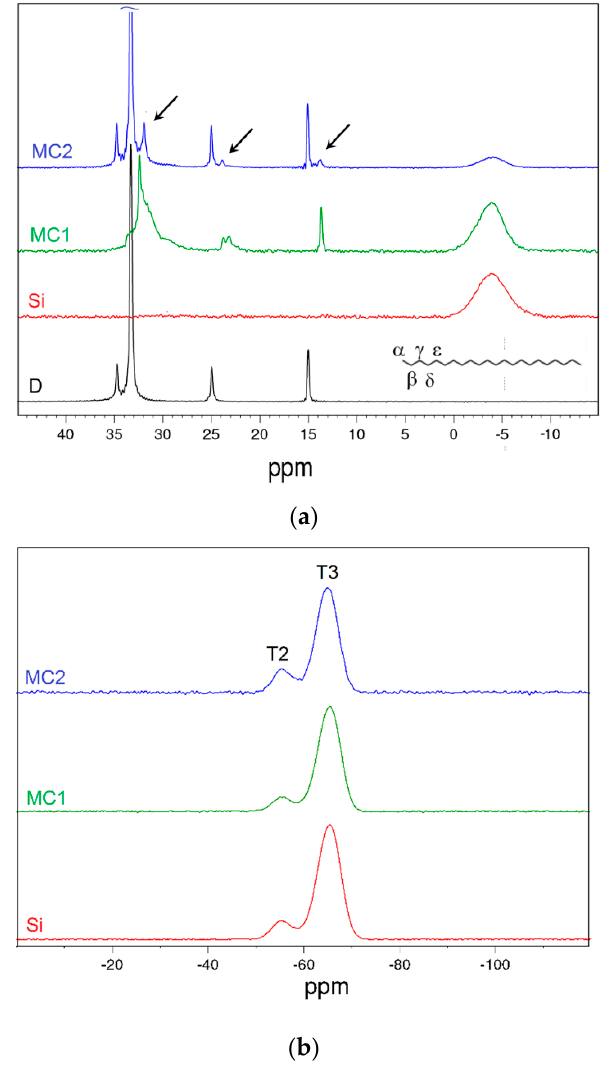
Figure 5. NMR spectra of docosane (D), MC1 and MC2 microcapsules and the neat organosilica microparticles (Si): ( a ) 13 C CP-MAS spectra with docosane carbon labeling and arrows to highlight rotator phase signals; ( b ) 29 Si CP-MAS spectra.